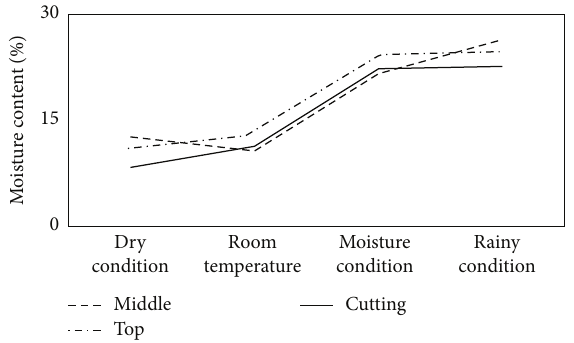
Figure 4: Moisture content of different portions of raw jute fiber.